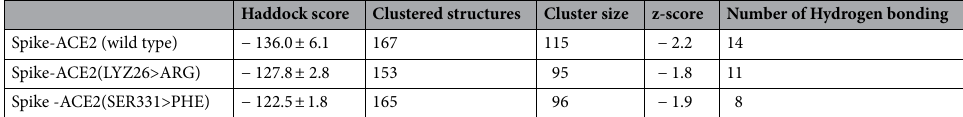
Table 2. Docking analysis of the wild-type and mutated ACE2 structure with the Spike monomer protein. The column of “Haddock score” in this table shows the score of the best-obtained complex, the column “Clustered structures” is the number of complexes that finally clustered by the haddock server (we set the initial docking number = 2000 and the number of structure for final analyses = 200) and Cluster size represents the population size of the cluster of the best-obtained complex and the final column is the z-score of this complex among this cluster.